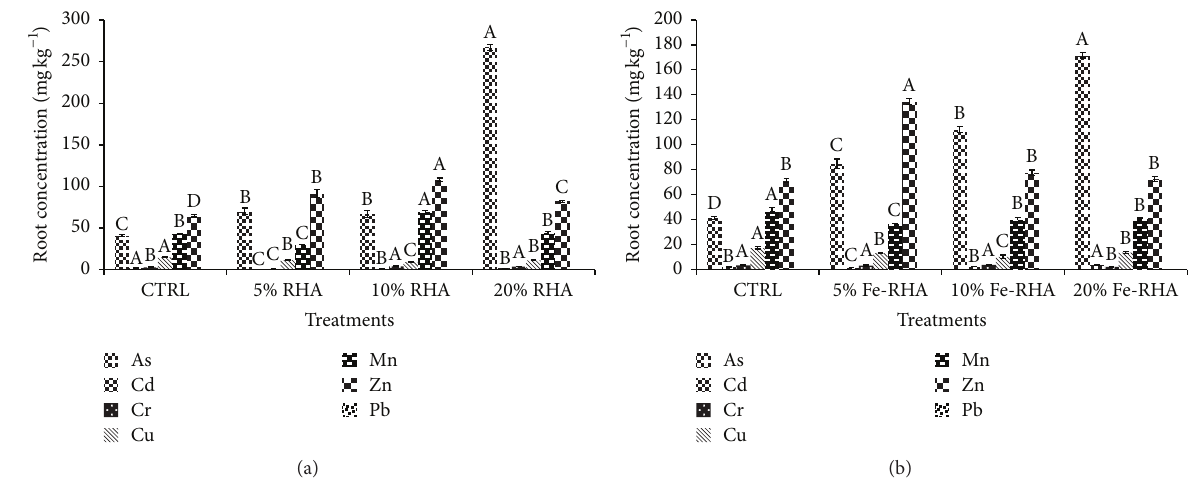
Figure 4: Concentration (mgkg −1 ) of As, Cd, Cr, Cu, Mn, Zn, and Pb in root of vetiver grass grown in gold mine amended with Fe-RHA and RHA (mean 𝑛 = 3 , ± SD). Different letters correspond to significant differences between rates of the same ash ( 𝑃 < 0.05 ). Pb was not detected.